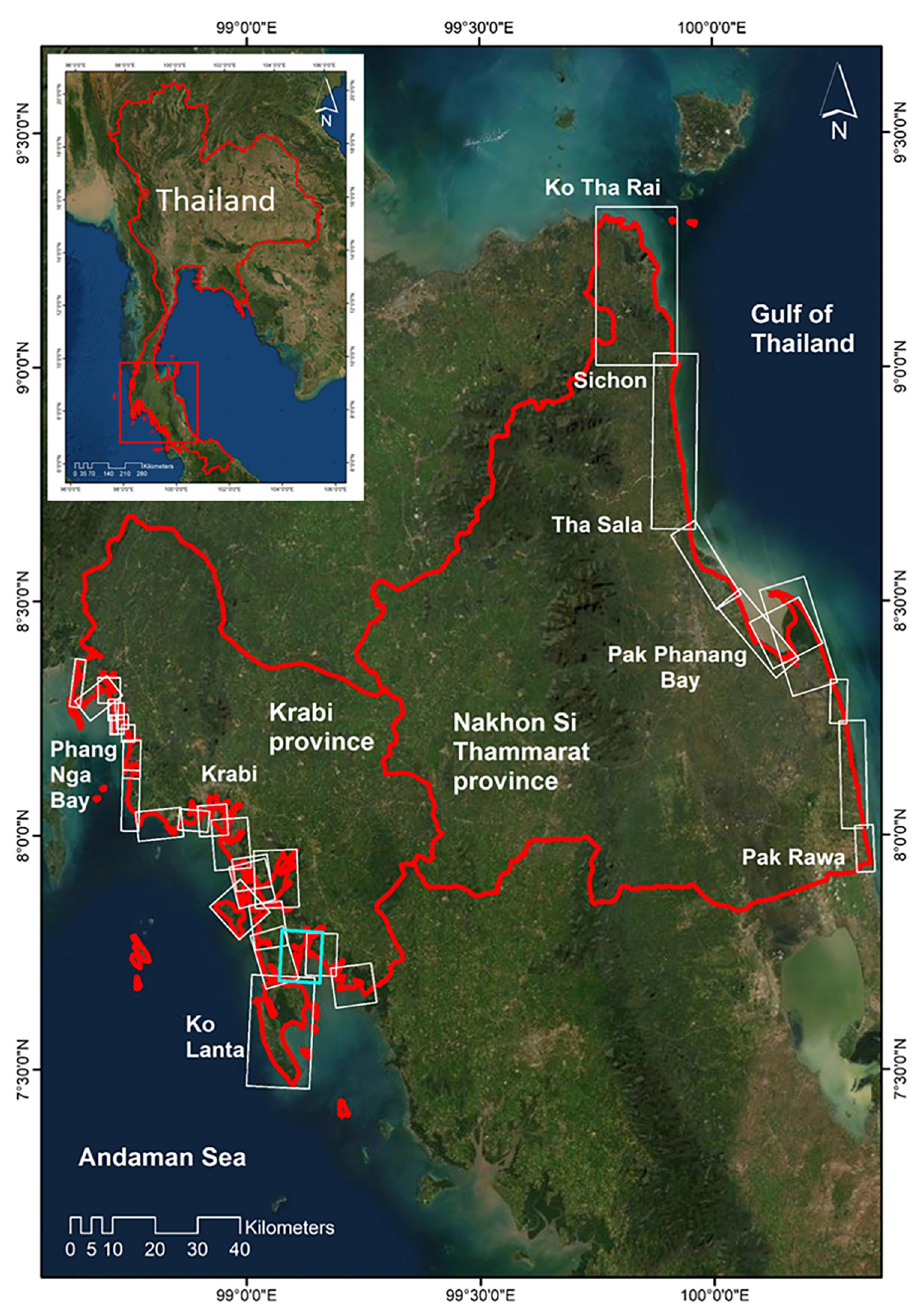
Fig 1. Location of the provinces of interest in Southern Thailand and identification of the coastal cell divisions for data processing along both coastlines. The blue contoured area is the only area where manual digitisation was necessary. Basemap satellite images accessed from World Imagery ESRI Tile Layer. Credits: Esri, Maxar, GeoEye, Earthstar Geographics, CNES/Airbus DS, USDA, USGS, AeroGRID, IGN, and the GIS User